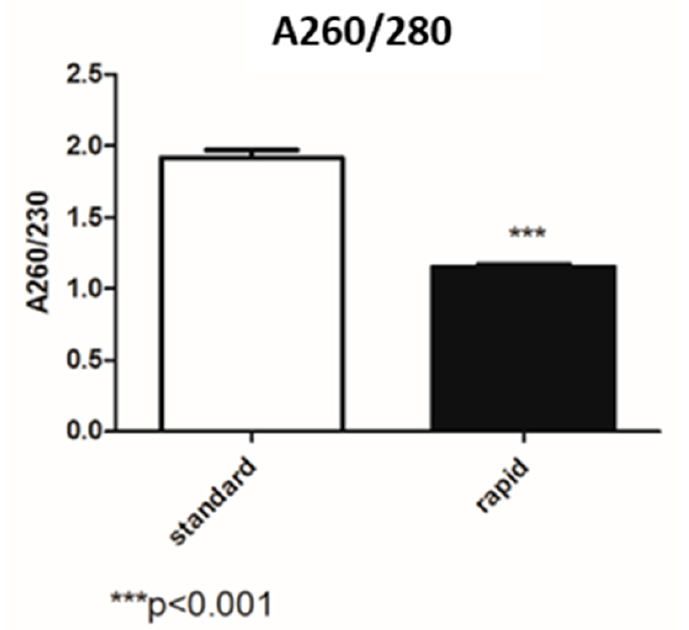
Figure 2. Comparison between the 260/280 ratio obtained by the standard and rapid extraction kits.